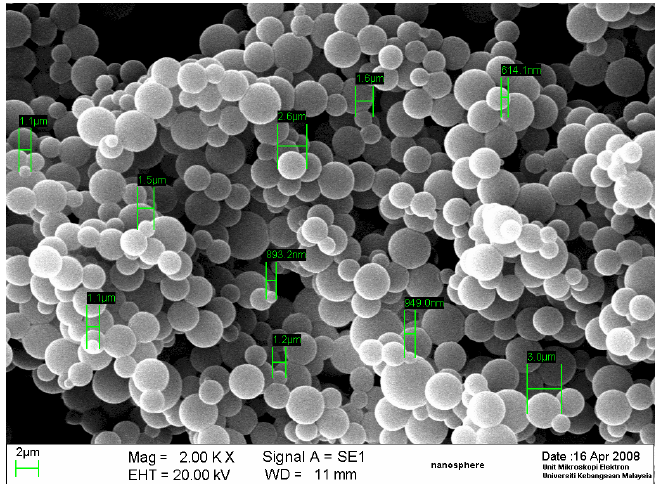
Figure 2. SEM image of acrylic microspheres prepared from